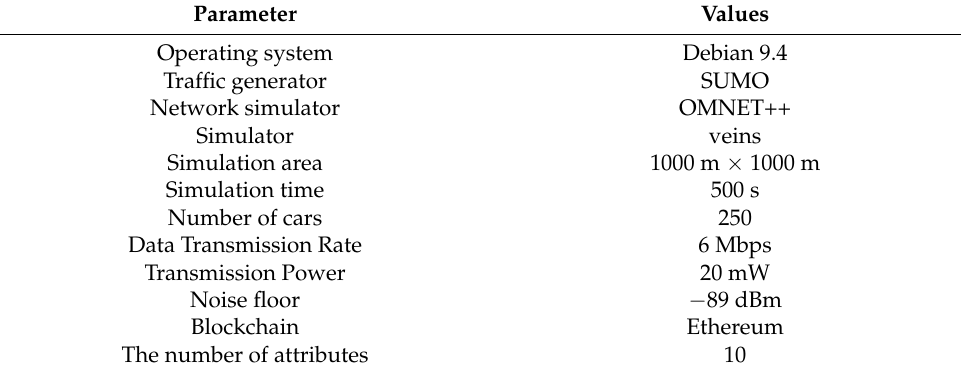
Figure 6. ( a ) OSM map of Shanghai ( b ) SUMO NET map of Shanghai. Table 5. Simulation